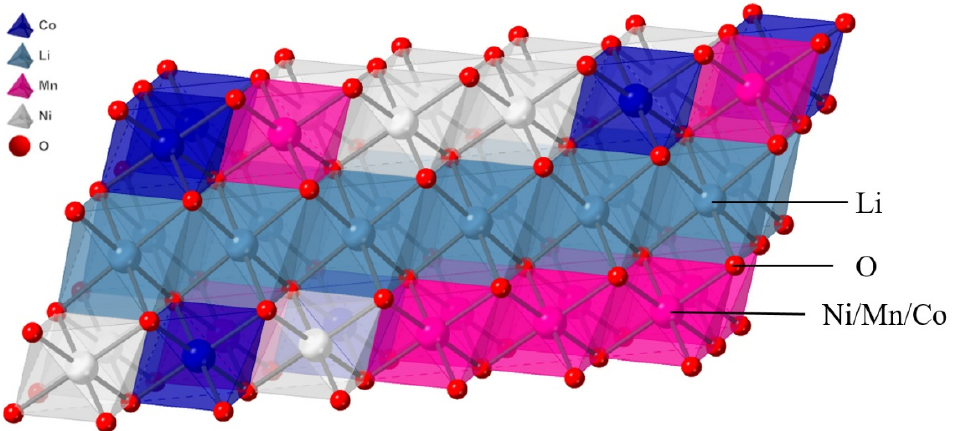
Figure 1. Crystal structure diagram of layered NMC materials. Ni, Mn, and Co are randomly distributed in the TM layer. Purple represents Mn, white is Ni, and dark blue is Co.